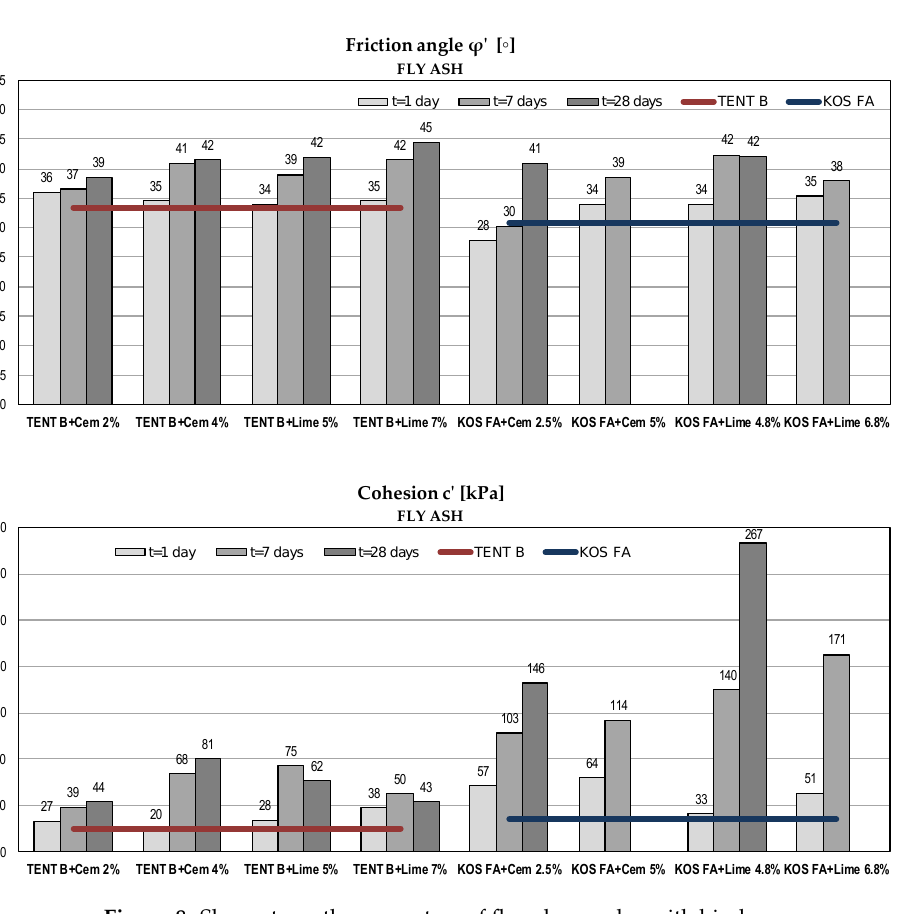
Figure 8. Shear strength parameters of fly ash samples with binders.